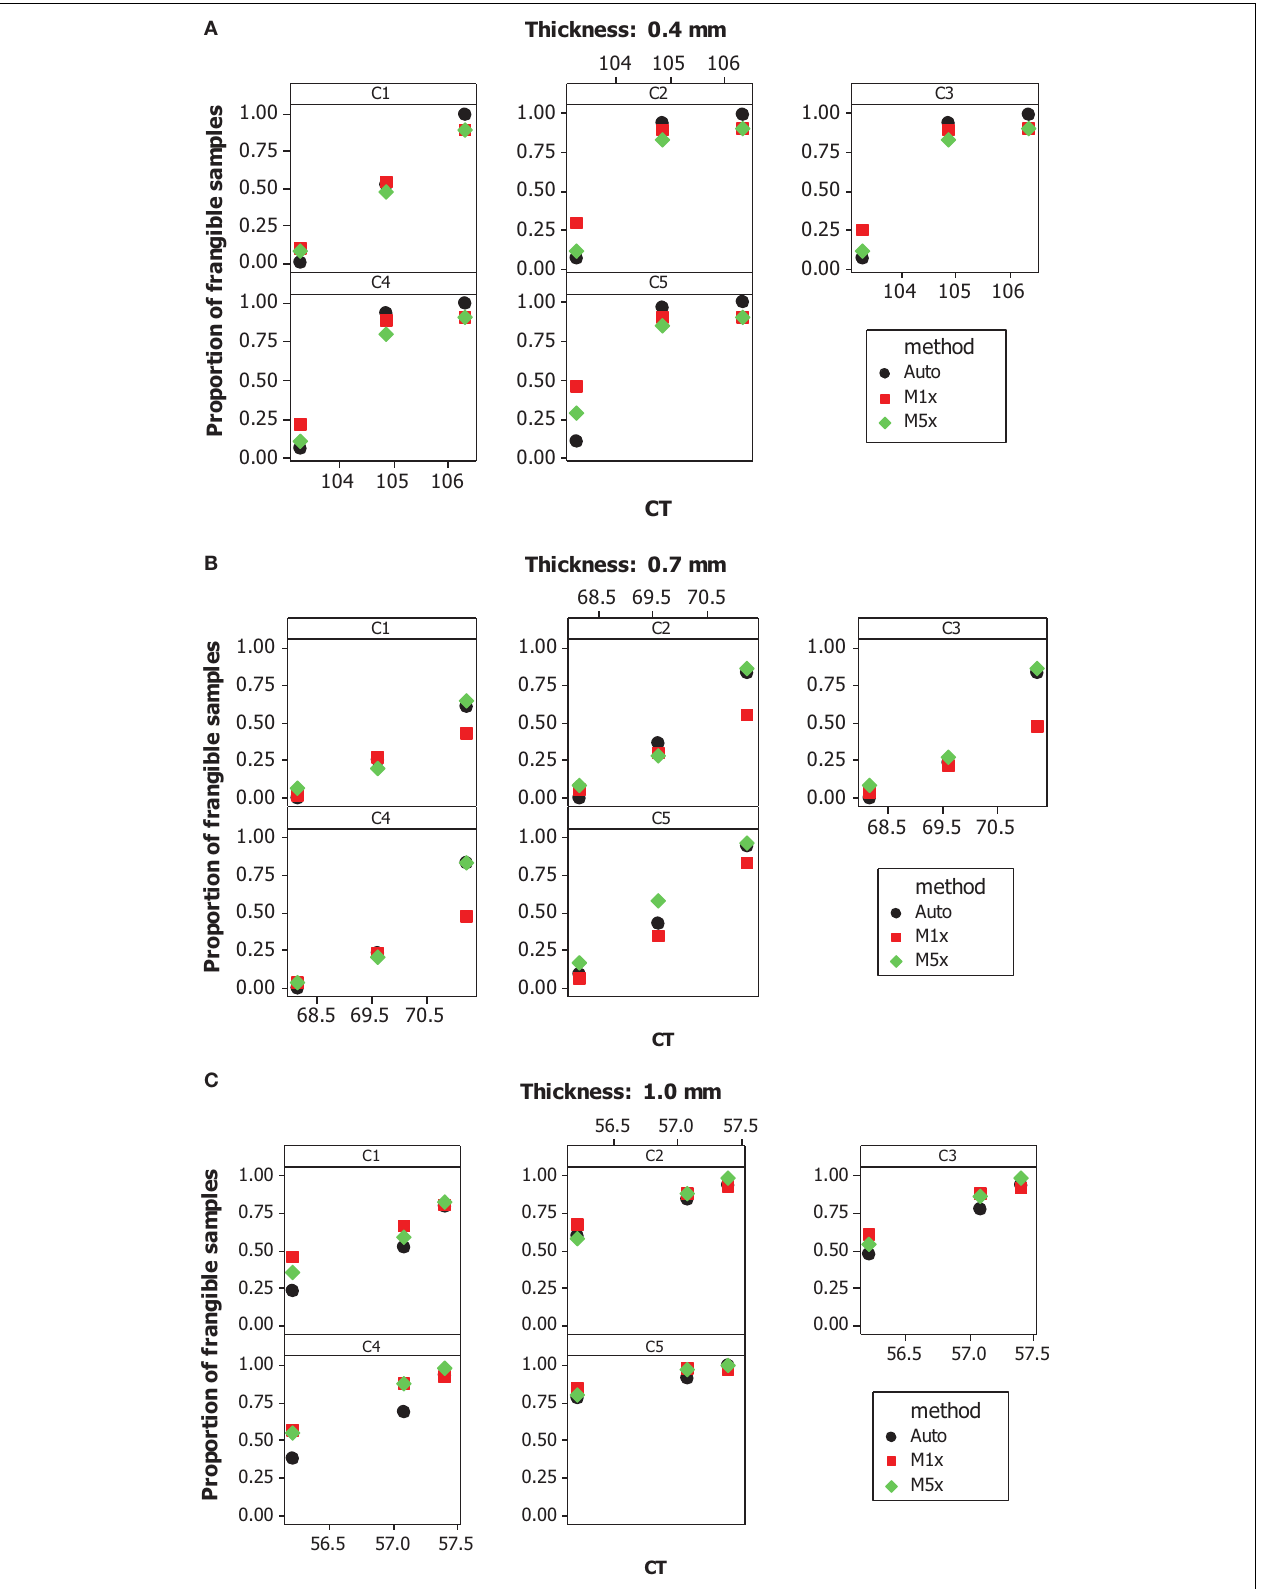
FIGURE 2 | The calculated frangibility probability based on different criteria as a function of central tension (CT) in MPa for various test method on (A) 0.4mm, (B) 0.7mm, and (C) 1.0mm glasses .